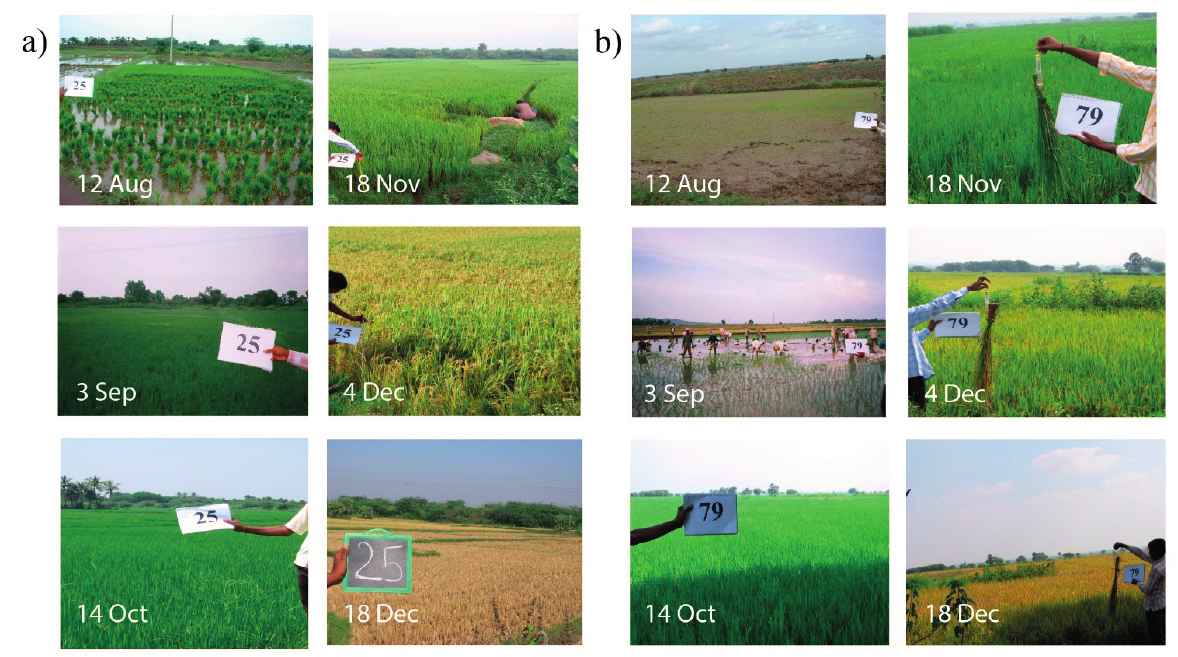
Figure 2. ( a ) Photos of the paddy rice site #25 (transplantation date of 12 August) at different